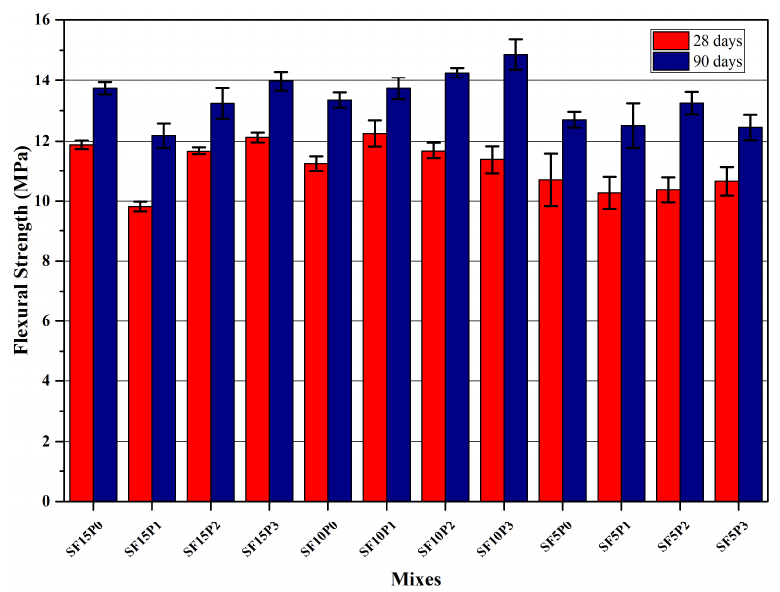
Figure 11. Flexural strength values of the SF samples.